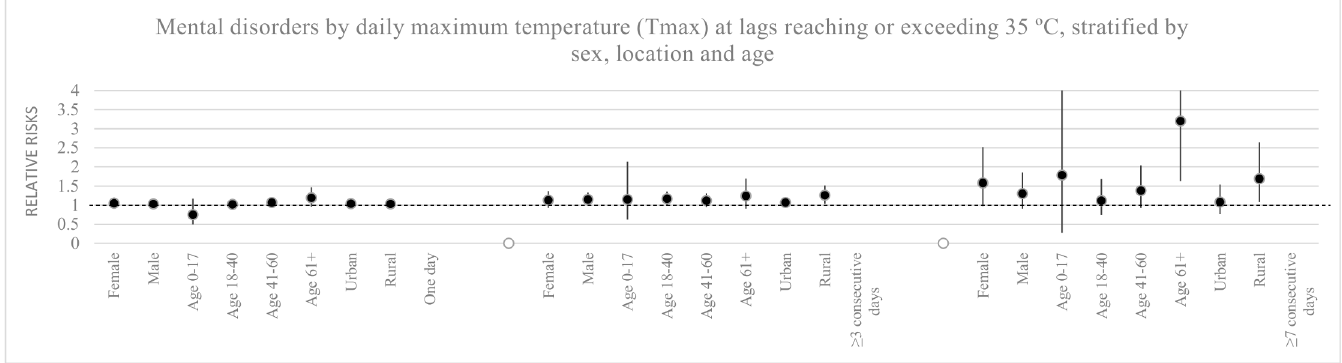
Fig 5. Mental disorders by daily maximum temperature at lags reaching or exceeding 35°C, stratified by sex, locations and age groups. During heatwaves at (cid:2) 3 consecutive days, admissions for mental disorders among rural populations and among men estimated a relative risk of 1.26 (1.04 – 1.52) and 1.15 (1 – 1.33). During heatwaves at (cid:2) 7 consecutive days, cases for the age group above 60 years and residents in rural areas increased with RRs estimating to 3.2 (1.63 – 6.29) and 1.69 (1.08 –